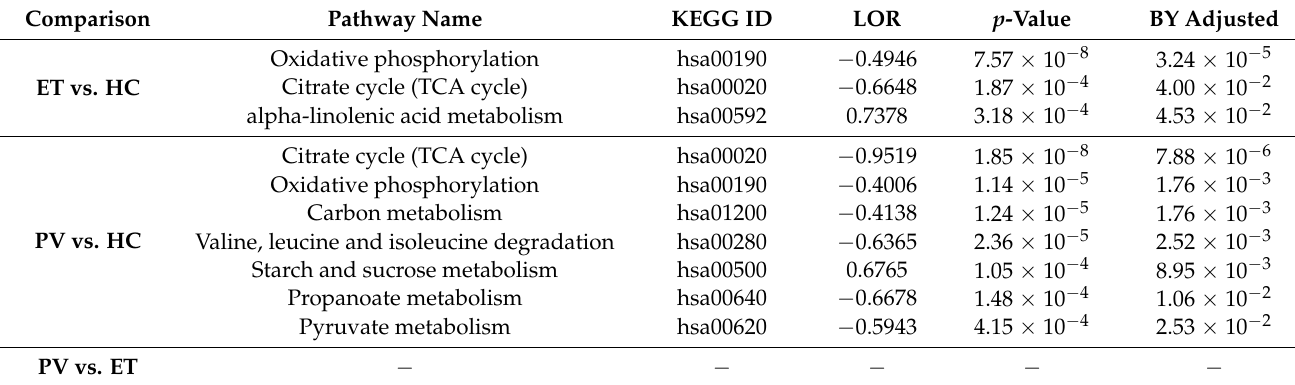
Table 1. Significantly enriched metabolic pathways identified in the gene set enrichment analysis (GSEA) for the GSE61629 transcriptomic